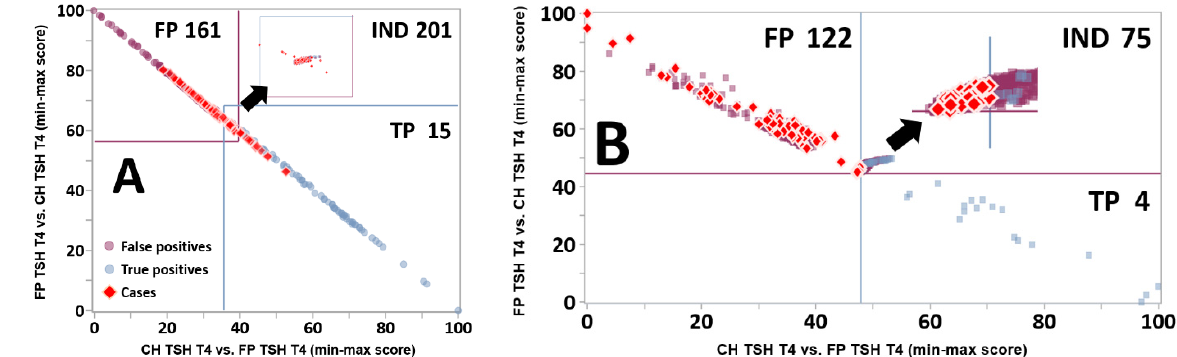
Figure 9. Resolution of Indeterminate cases by the Zoom Plot. Legend: (Panel A ): Same Dual Scatter Plot for location Georgia as shown in Figure 4A, overlaid with red diamonds representing individual false positive cases from the Verification cohort (location Georgia, condition FP TSH T4, N = 467). The insert in the top right quadrant is a magnification of the Indeterminate zone. Quadrants are defined as in the legend of Figure 4. (Panel B ): 900 Indeterminate cases (see Figure 4) from the Validation cohort overlaid with the 201 Indeterminate cases from Panel A. The insert in the top right quadrant is a magnification of the intersection of the lines.